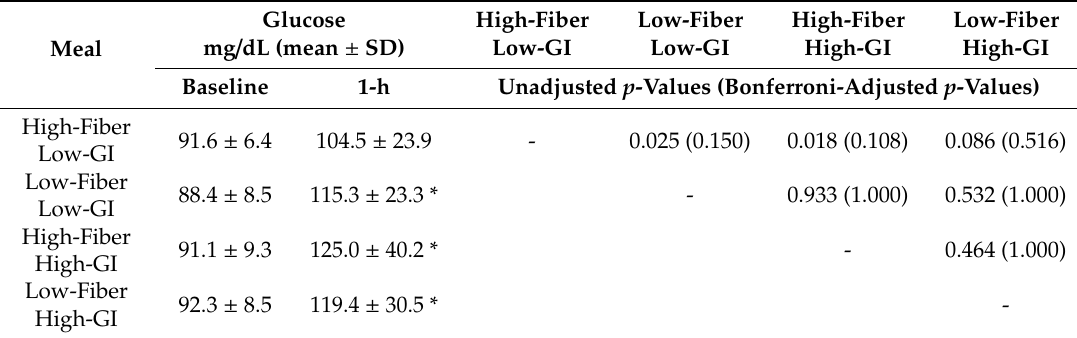
Figure 2. Glucose concentrations over time in response to four meals di ff ering in glycemic index (GI) and fiber content. Dashed lines represent individual subject responses. Solid lines represent mean responses for all subjects. See text and Table 2 for statistical comparisons. Table 2. Blood glucose responses 1-h postprandial: Comparisons between